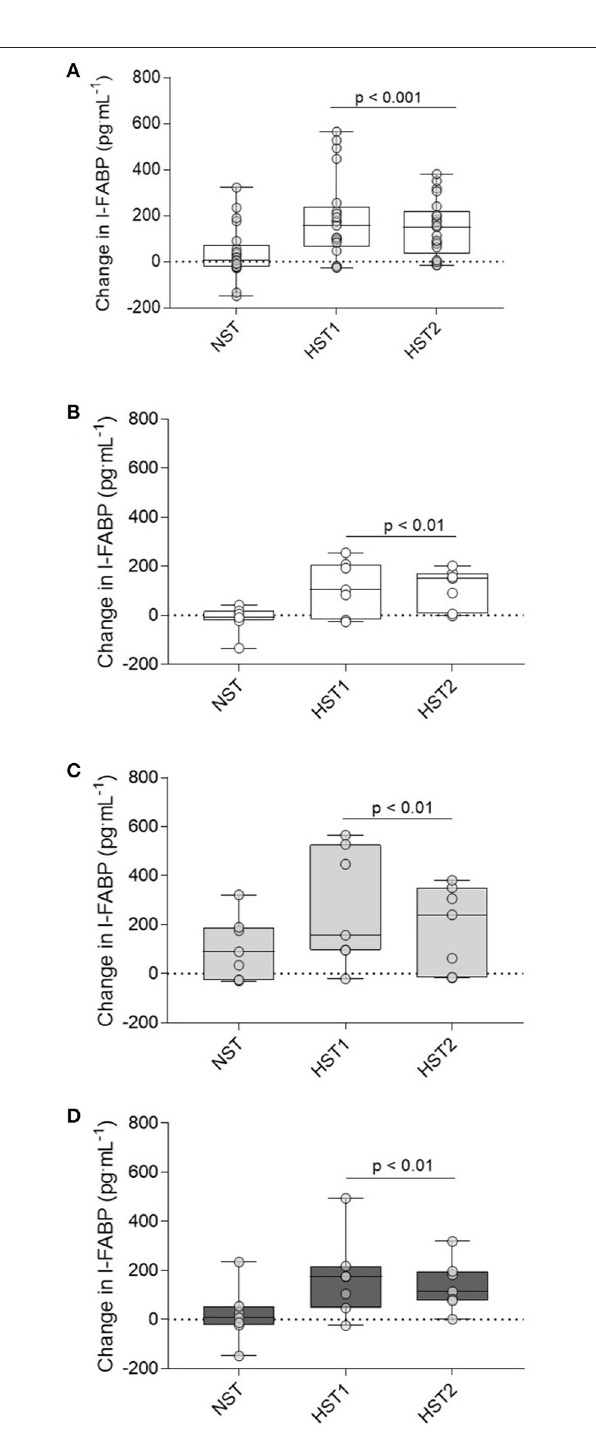
FIGURE 5 | Delta change in I-FABP from pre to post-exercise measurements for the NST, HST1, and HST2 trials for the total participant cohort ( n = 21; A ), and the delta change from pre to post-exercise for the CON (B) , HYP (C), and HOT (D) groups . Box plots show all individual data points (dots), the 25 and 75th interquartile ranges (boxes), and the median (mid-line). Whiskers illustrate the highest and lowest value. P -values indicate differences relative to the pre-trial resting values within each experimental group and between normoxic and hypoxic